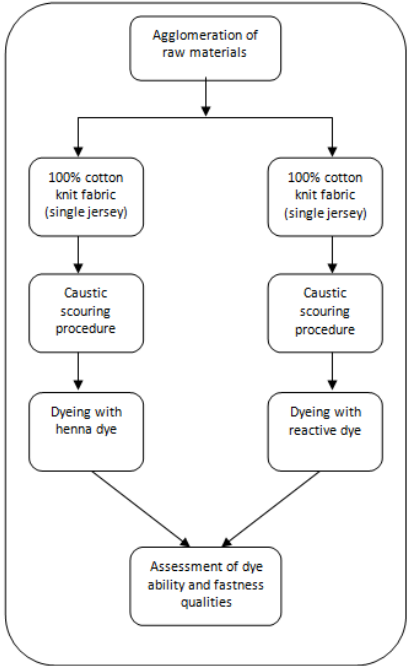
Figure 1. Flowchart illustration of experimental